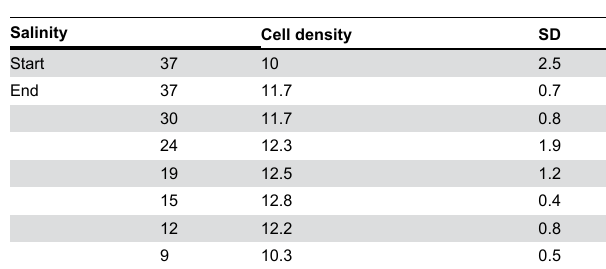
Table 1. Mean cell density (x10 4 cells mL -1 ) and standard deviation (SD; n = 3) at the start and end (12 h) of the preliminary experiment for verifying the occurrence of cell growth or mortality at the different salinities during 12-h exposures in darkness.